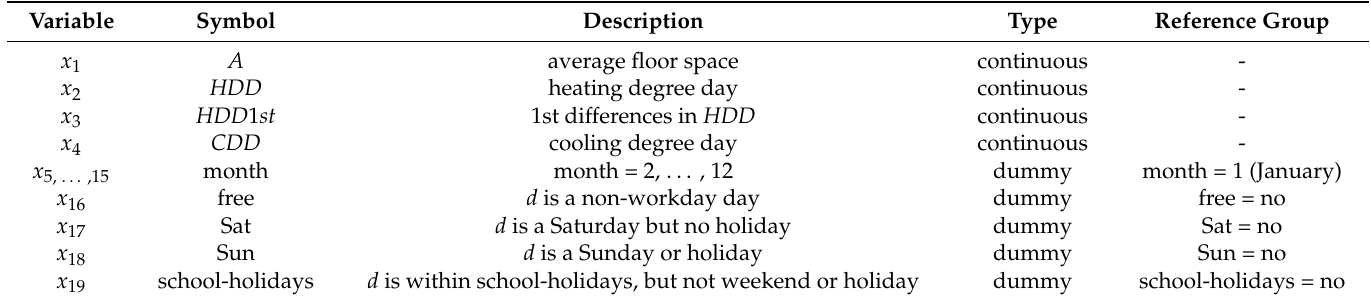
Table A2. Description of explanatory variables in service sector models.